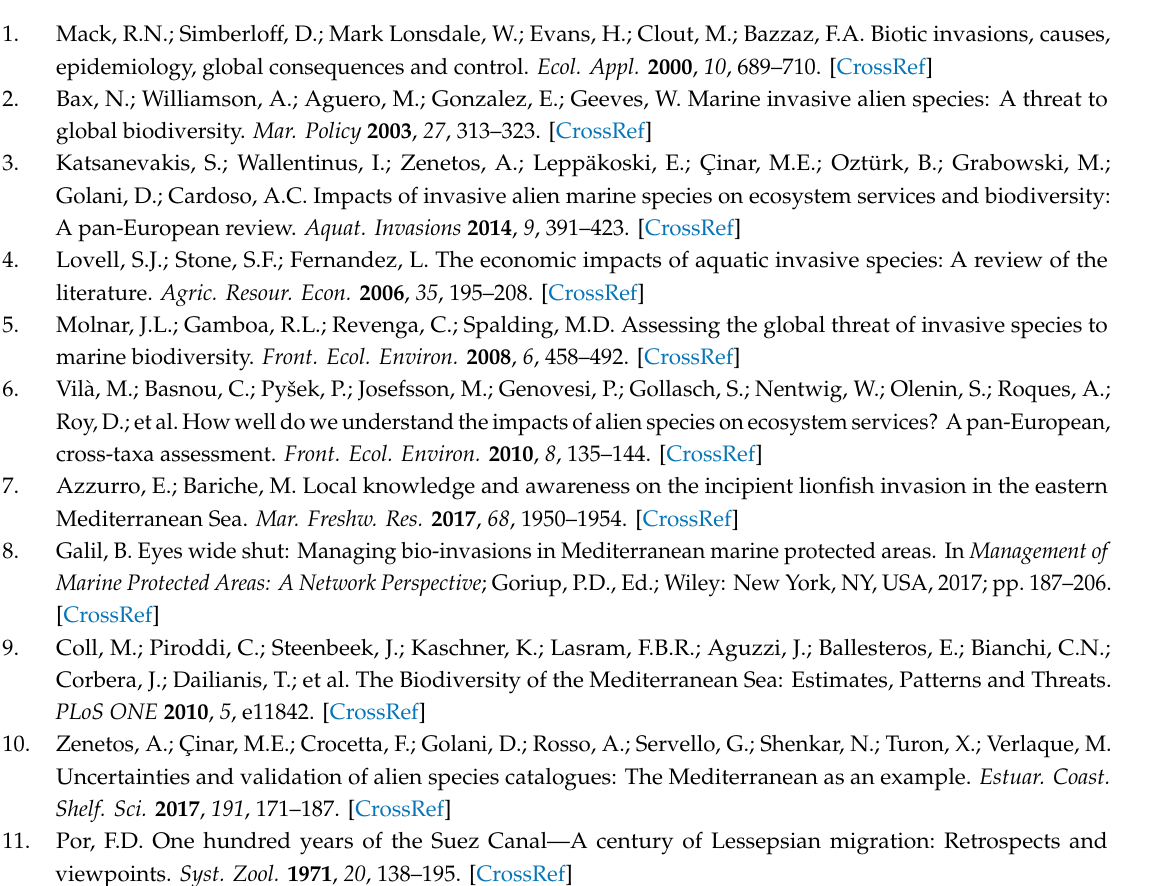
Figure S1: BI phylogram based on concatenated data set including both targeted genes (CR and COI), Table S1: Species, locality of origin, available sequence data from targeted genes, and codes / Genbank accession numbers of individuals used in the analyses., Table S2: Frequency and Accession numbers of CR haplotypes, Table S3: Frequency and Accession numbers of COI